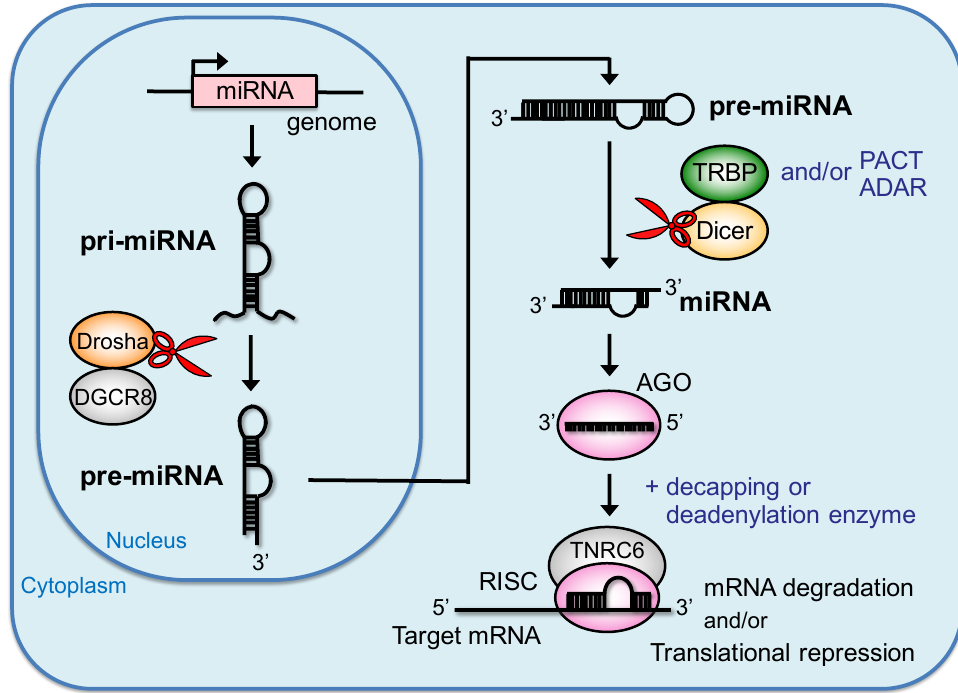
Figure 1. RNA silencing directed by endogenous miRNAs. The primary miRNA (pri-miRNA) is transcribed from the genome and processed into precursor miRNA (pre-miRNA) by the endoribonuclease Drosha in the nucleus. After processing, the pre-miRNA is exported to the cytoplasm and processed into miRNA duplexes by the endoribonuclease Dicer. One strand of the miRNA duplex is bound to Argonaute (AGO) and forms RNA-induced silencing complex (RISC) with trinucleotide repeat-containing gene 6 (TNRC6) and decapping or deadenylation enzymes for mRNA degradation or translational repression of